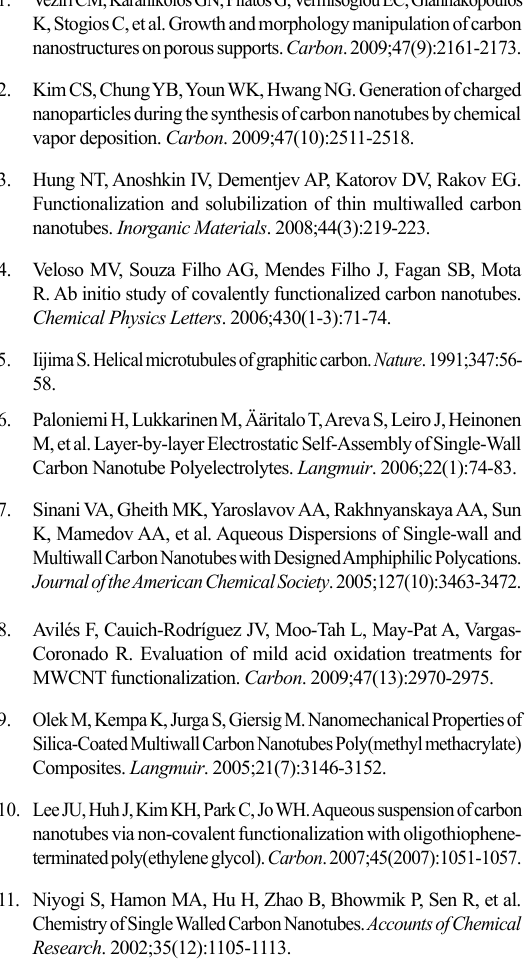
= 355 nm) (a) of the silica nanoparticles and PAH-MWCNTs-SiO Figure 7. PL spectra (λ ex SiO . The silica nanoparticles were prepared according to the specific procedures used to prepare the 2